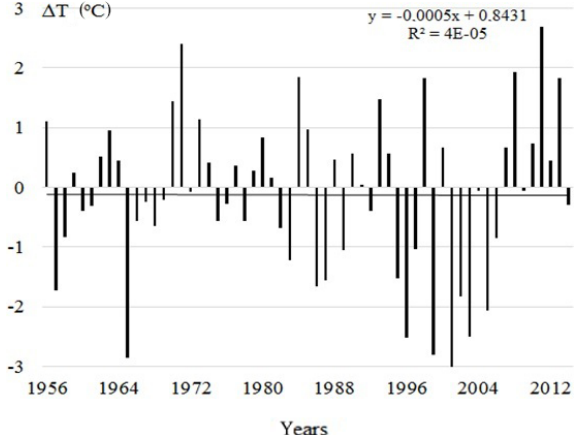
Figure 11. Deviation of annual temperature from the long-term av- erage (1956–2012) and trend for the Bulunkul meteorological sta- tion.